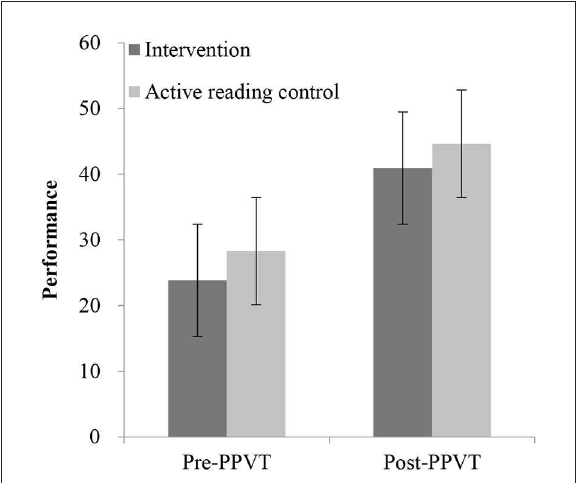
FIGURE6 PPVT pre- and post-performance between the intervention group and active reading control group. PPVT, receptive vocabulary skills.